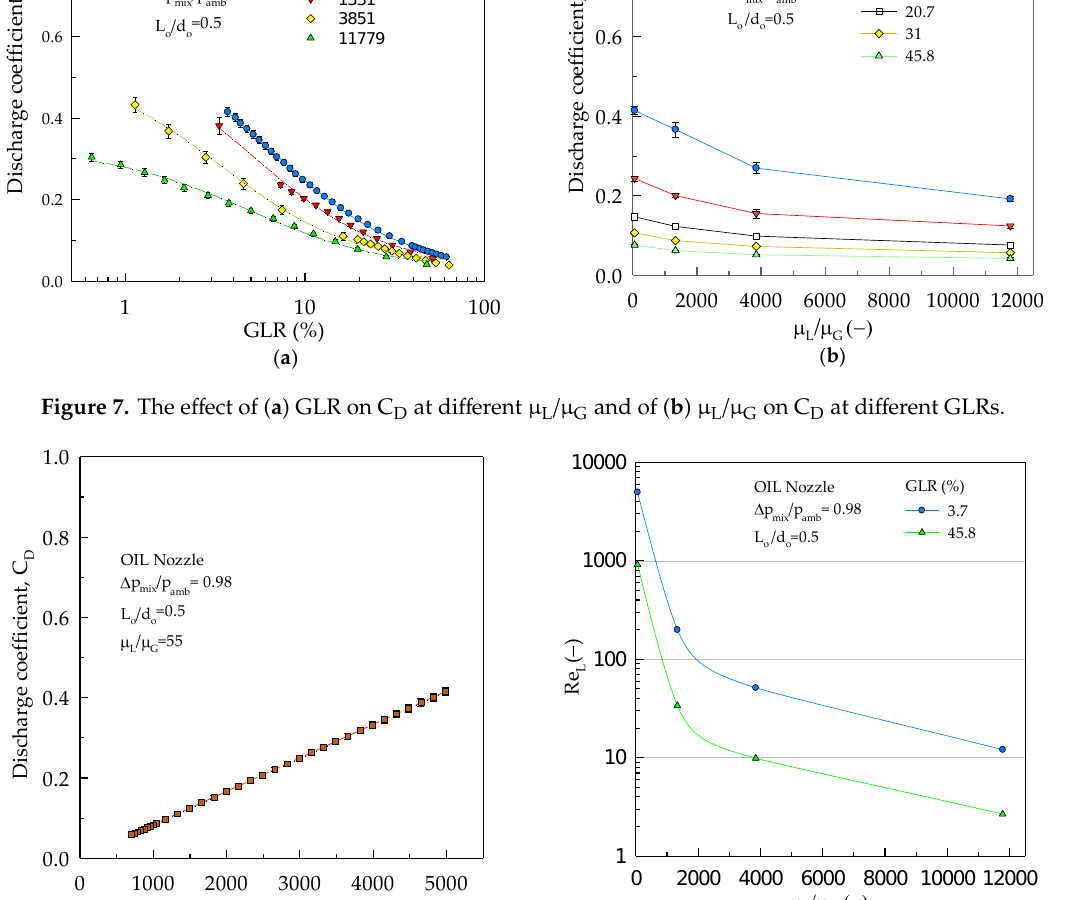
/ µ ff erent µ L G and Re L at di